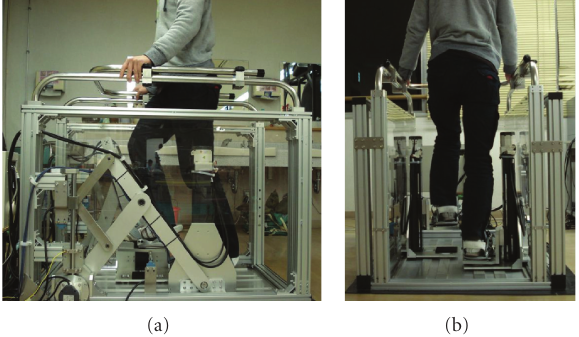
Figure 6: The GaitMaster5 gait rehabilitation system (picture courtesy of Dr. Hiroaki